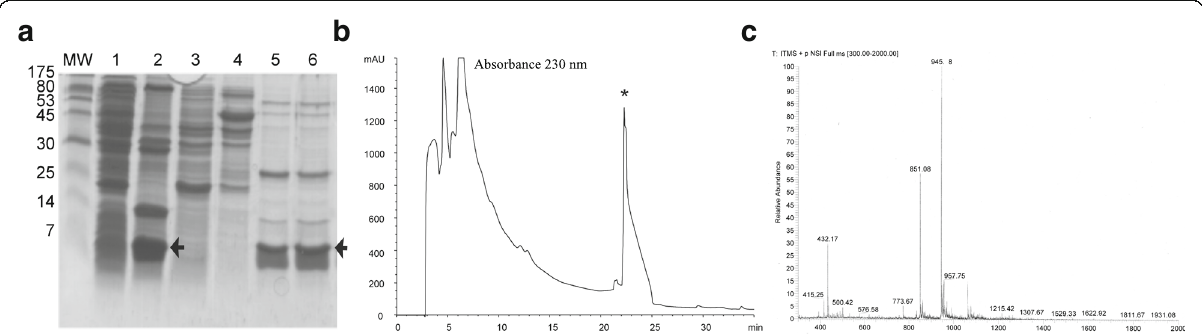
Fig. 3 SDS-PAGE and HPLC separation of HisrMlat1 from Origami strain cells. a SDS-PAGE. Left lane shows the molecular weight markers (kDa). Lane 1: the protein extract from cytoplasm. Lane 2: the protein content in the cytoplasmic soluble fraction (an arrow indicates the relative molecular size of the expected HisrMlat1). Lanes 3 and 4: the proteins that were not bound to the Ni-NTA column. Lanes 5 and 6: the eluates from the Ni-NTA after 250 mM imidazole. The protein bands corresponding to HisrMlat1 are indicated by an arrow. b rpHPLC. The product obtained from the affinity column was directly loaded into the C 18 reverse column (approx. 500 μ g of protein). The fraction labelled with an asterisk had the molecular mass expected for the recombinant HisrMlat1. This fraction was lethal to mice. c Mass spectrometry. HisrMlat1 from either M15 or Origami strain cells has the same molecular mass, namely 8,499.6. The main m/z ions are shown [945.8] +9 , [851.08] +10 , [773.67]